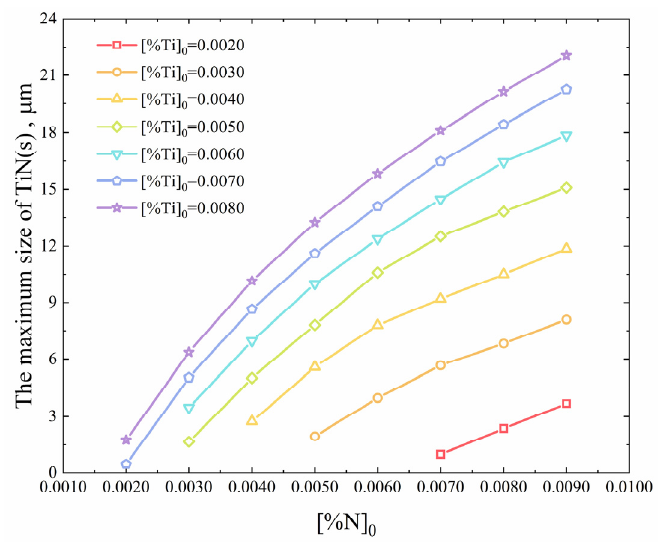
ff erent initial Ti and N